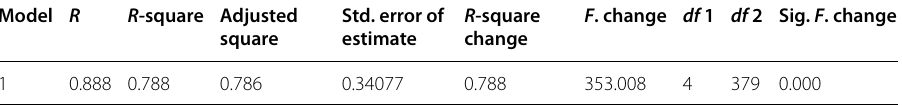
Source: analysis